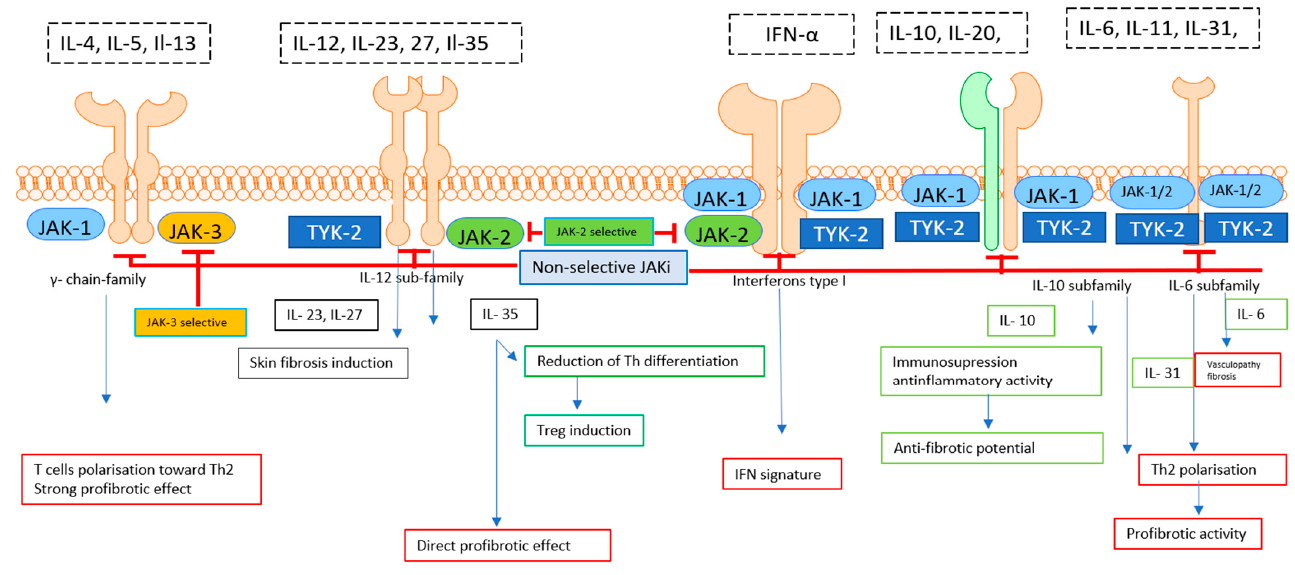
Figure 1. Cytokine network in systemic sclerosis.